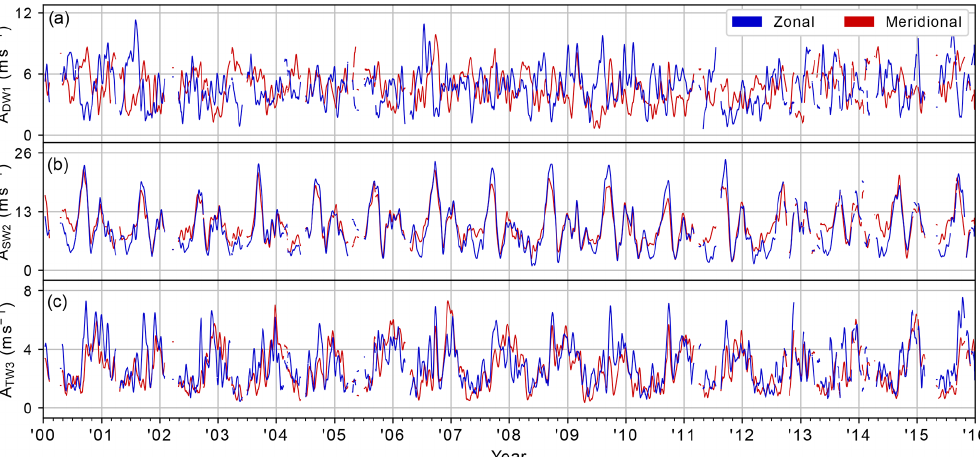
Figure 2. Amplitude of DW1 (a) , SW2 (b) , and TW3 (c) in SuperDARN zonal (red) and meridional (blue) meteor winds between the years 2000 and 2016.